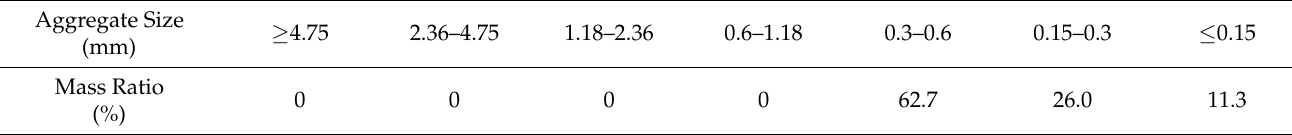
Table 6. Gradation of pearl river fine sand (the fineness modulus is 1.51).